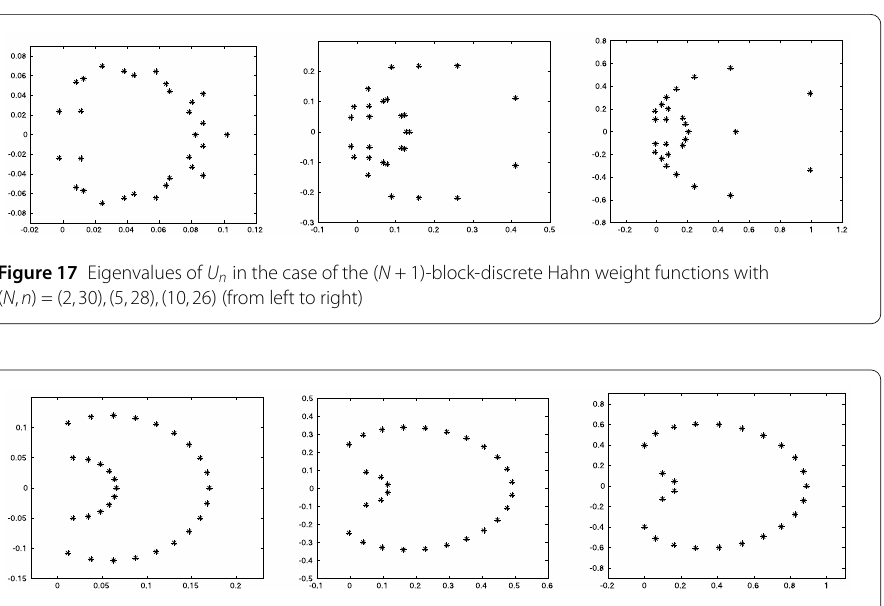
to be true for N = [1,2,3,4,9], 2 ≤ n ≤ 30, and false in only the five cases: ( N , n )